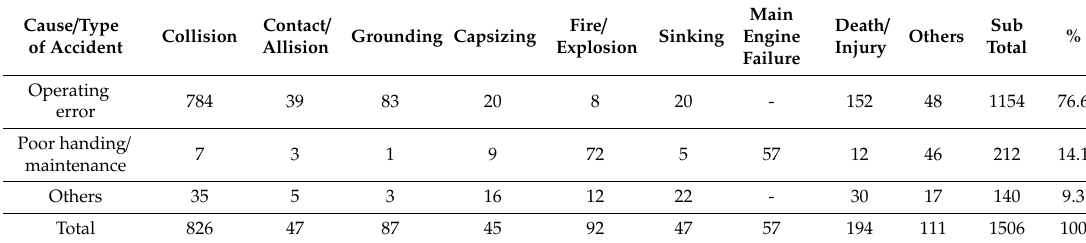
Table 1. Causes of maritime accidents (2015–2019).